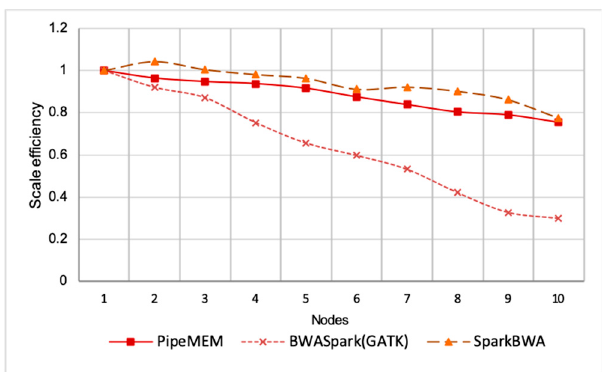
Figure 9. Comparison of scale efficiency between PipeMEM, BWASpark, and SparkBWA. It’s a normal trend that as the node increases, the efficiency of the program decreases. This decline is caused by the overhead of parallelism. The reason why the efficiency of SparkBWA increases in a two-node situation is more or less because its performance in single-node is too bad. The trend of the efficiency of PipeMEM and SparkBWA is similar to each other. Besides, the efficiency of BWASpark (GATK) decreases the fastest. This implies its higher overhead in parallelism.